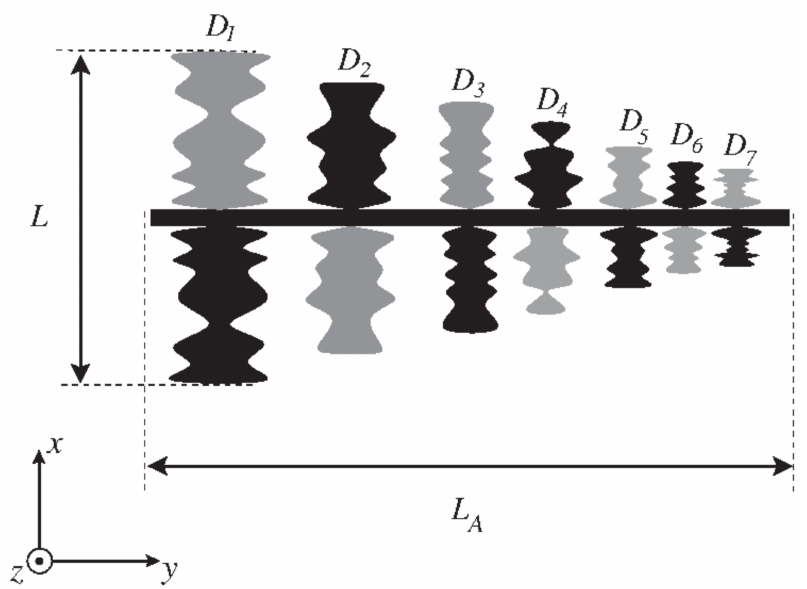
Figure 6. PLPDA design with modified dipoles using optimized Fourier coefficients